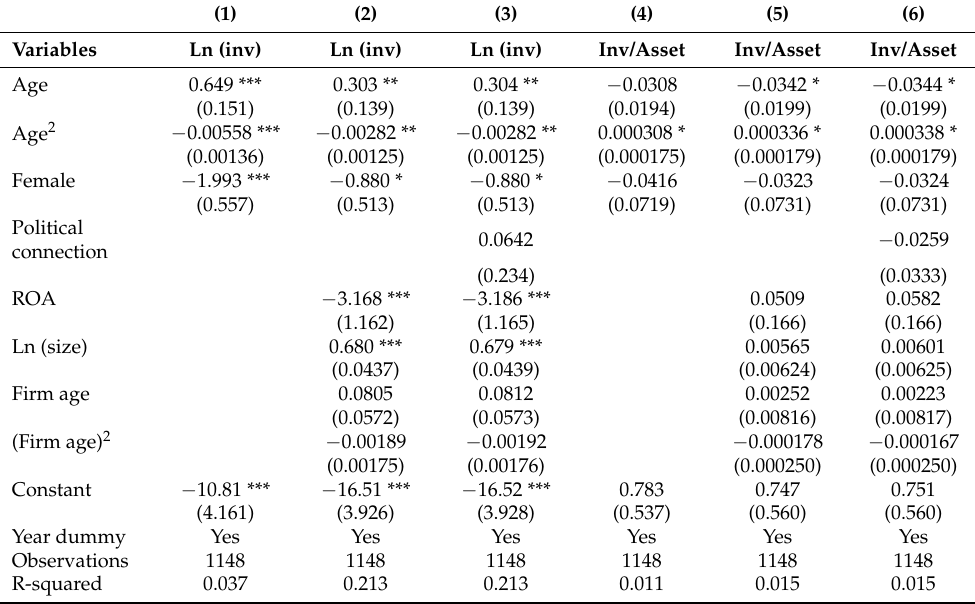
Table 6. Chairperson characteristics and environmental investment in